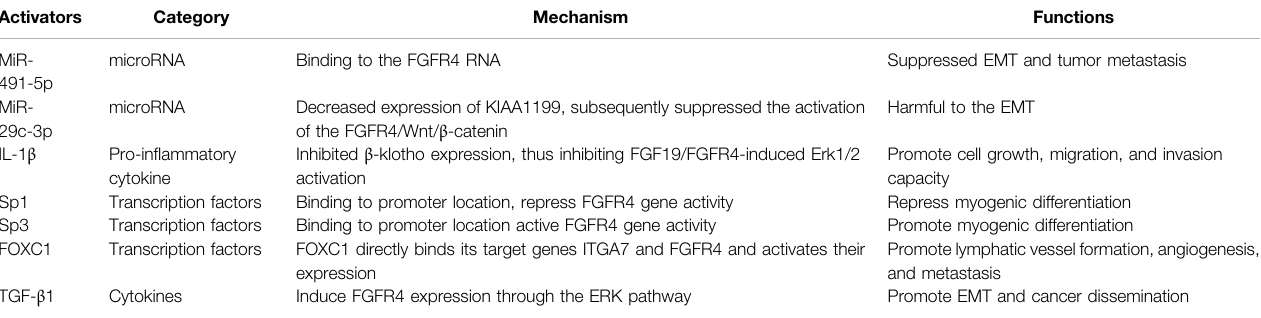
TABLE 1 | Novel activators of FGFR4 in cancer